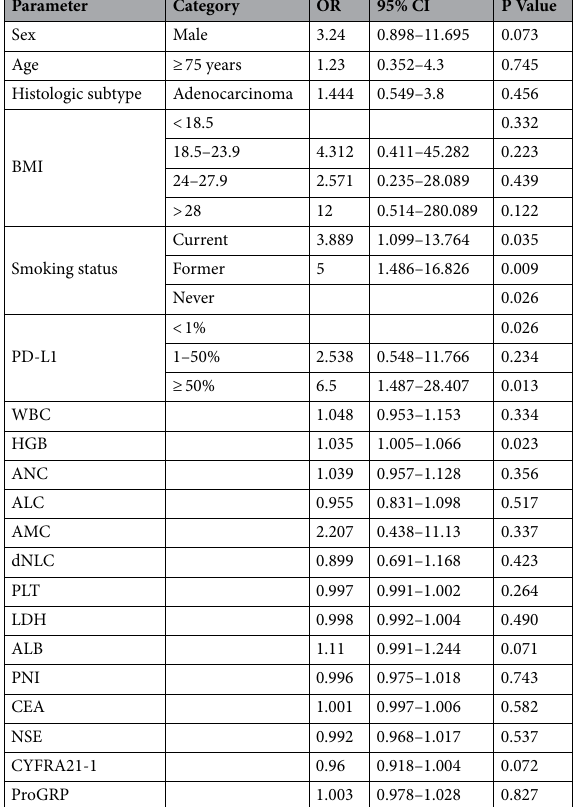
Table 2. Univariate logistic regression